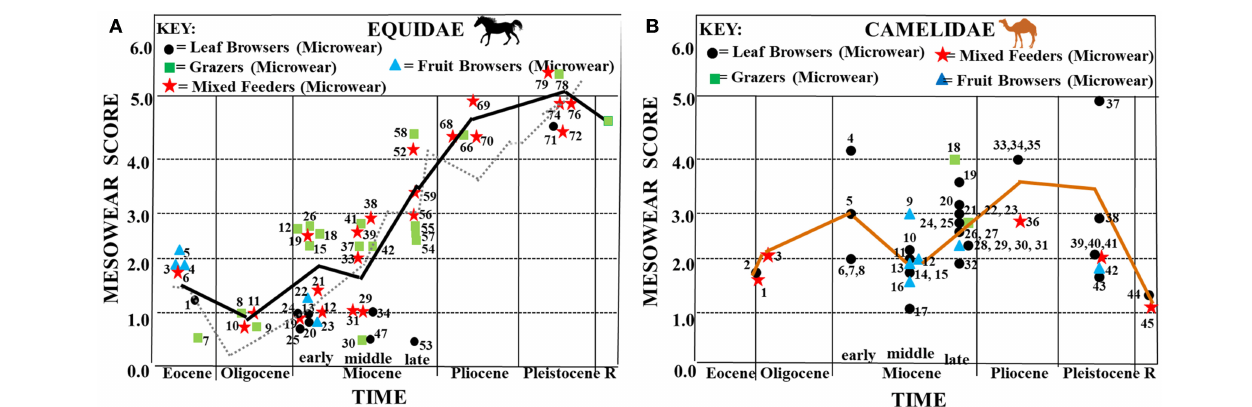
FIGURE 4 | Synthesis of mesowear and microwear results for fossil equids (A) and camelids (B) plotted along a time axis. (A) Average mesowear scores for each equid taxon (mesowear scores from Mihlbachler et al., 2011) are shown plotted along a horizontal axis representing geological time. Symbols used for each mesowear score represent dietary assignment assessed via microwear (data from Semprebon et al., 2016). Key to microwear dietary assignment: circles = browsers, squares = grazers, stars = seasonal or regional mixed feeders. Black trend line = mesowear trend line using the same taxa from the same localities that had both mesowear and microwear data available ( N = 72). Gray dotted line = mesowear trend line for those taxa with only mesowear scores available ( N = 6,498). Key to taxa: 1 = Basal Eocene equid—Species A, 2 = Basal Eocene equid—Species B, 3 = Basal Eocene equid—Species C, 4 = Basal Eocene equid—Species